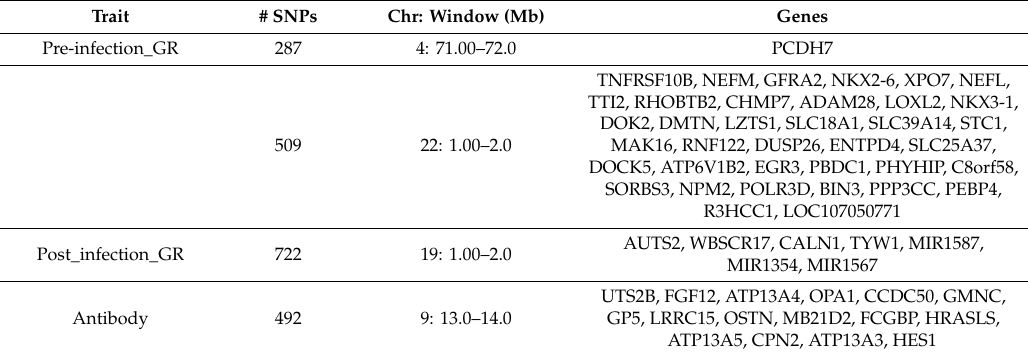
Table 6. Positions and genes located in 1 Mb windows with ≥ 1% of genetic variance for NDV response